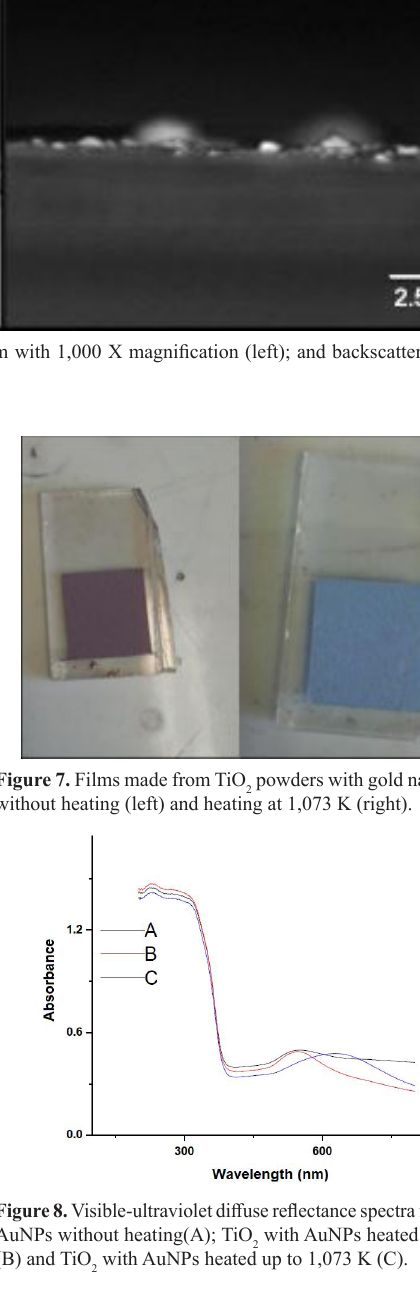
Figure 8. Visible-ultraviolet diffuse reflectance spectra for TiO AuNPs without heating(A); TiO with AuNPs heated up to 723 K 2 (B) and TiO with AuNPs heated up to 1,073 K 2